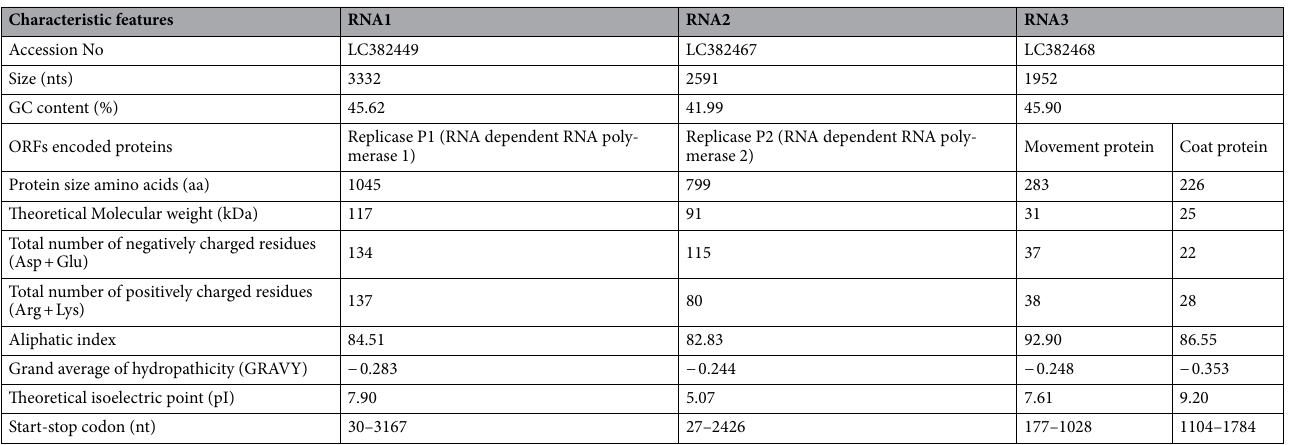
Table 2. Characteristic features of RNA1, RNA2 and RNA3 of